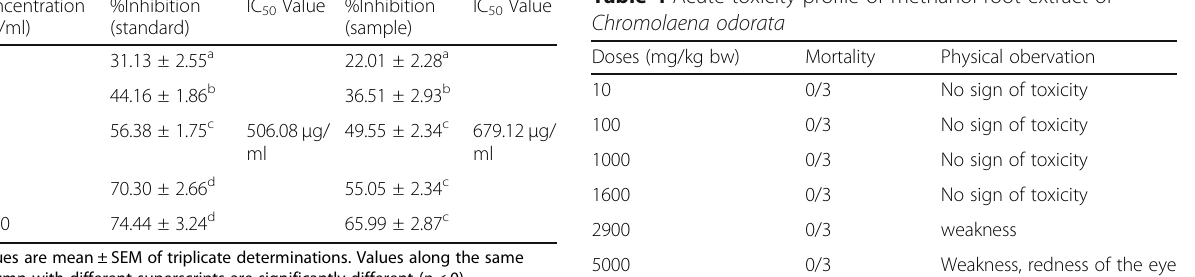
Table 4 Acute toxicity profile of methanol root extract